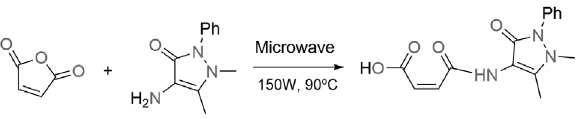
Figure 2 - Synthesis of ( Z )-4-((1,5-dimethyl-3-oxo-2-phenyl- 2,3dihydro-1 H -pyrazol-4-yl) amino)-4-oxobut-2-enoic